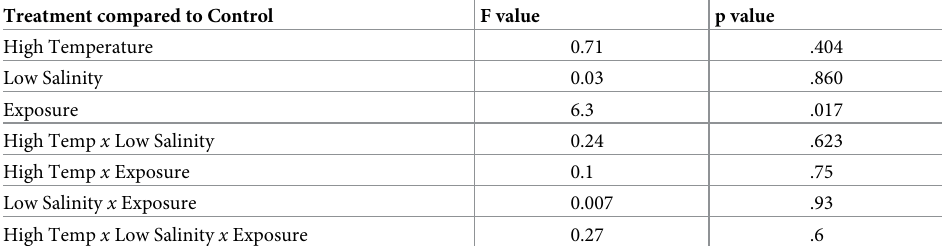
Table 2. ANOVA results from the Pulsed 3-Stressor